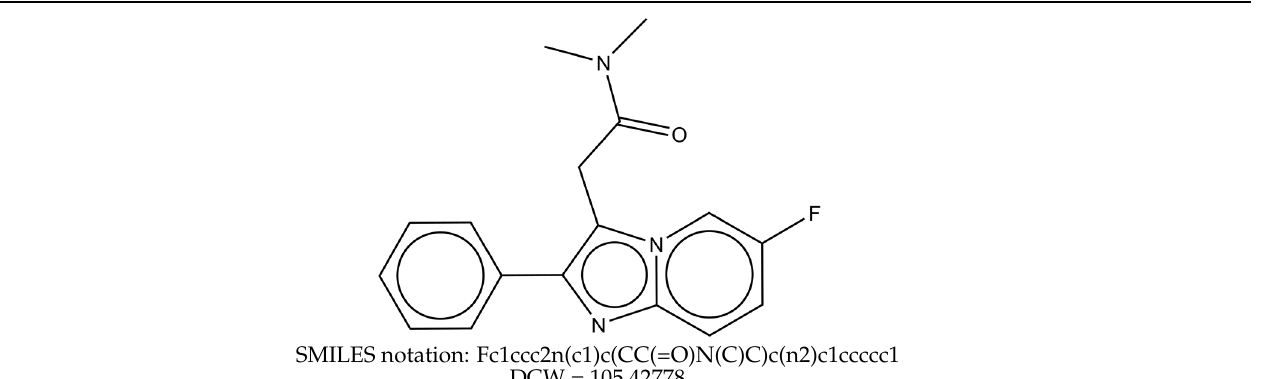
Table 2 molecular graph-based descriptors were omitted to achieve an easier interpreta- tion, while the full list of molecular descriptors, both based on the molecular graph and the SMILES notation is shown in Table S4 (Supplementary Material). Table 2. The example of DCW(3,7) Table 2. The example of DCW(3,7) calculation.